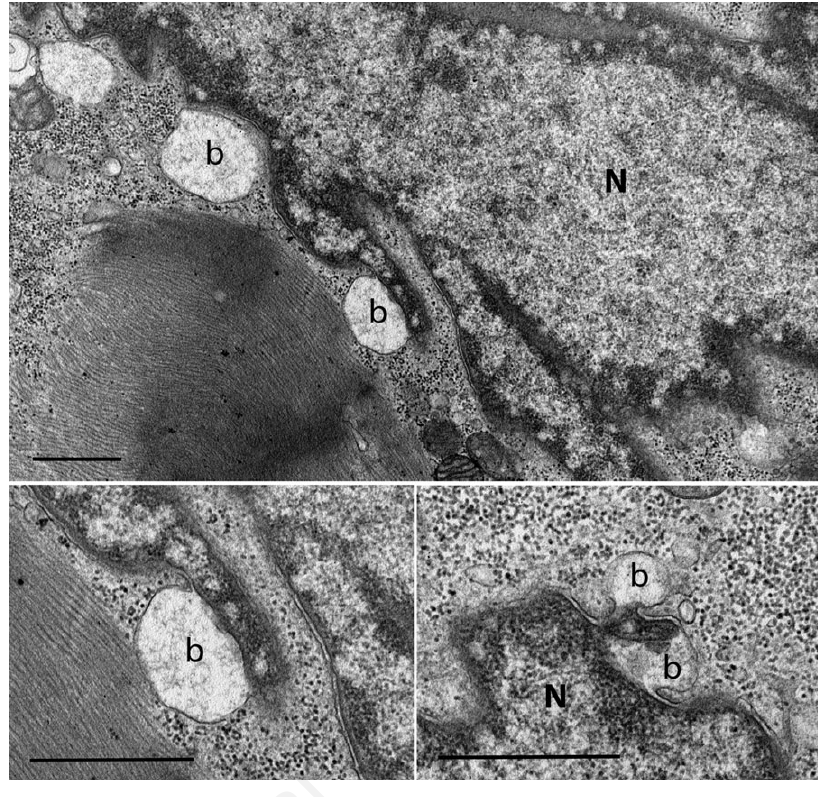
Figure 6. Electron microscopy of endomyocardial biopsy (of patient III:1 of the family affected with the Phe237Ser LMNA mutation). The shape of the cardiomyocyte nucleus (N) in the upper panel is extensively convoluted and the nuclear membrane shows herni- ations or blebs (b) to the cytoplasm. The lower left panel is a detail from the upper panel. The lower right panel shows another example of nuclear blebs in a cardiomyocyte nucle- us. The scale bar corresponds to 1